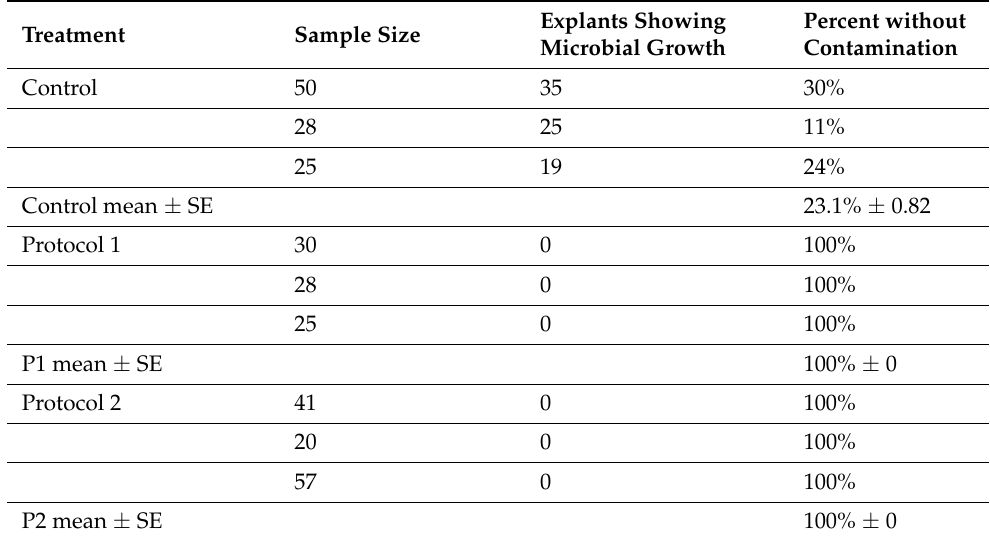
Table 1. Efficacy of stem bud sterilization using the two protocols, P1 and P2, for explants from hybrid hazelnut explants. The standard error is shown for the percentages calculated. Treatment Sample Size